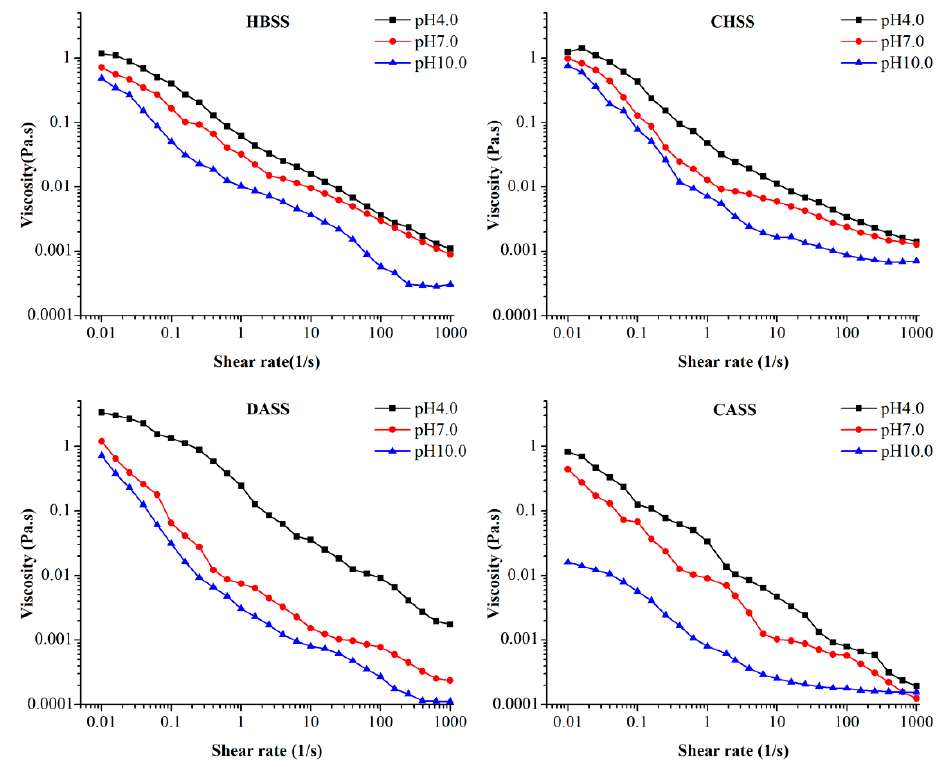
Figure 3. Variation of apparent viscosity of 1% MLPs at different pH values at 20 °C.